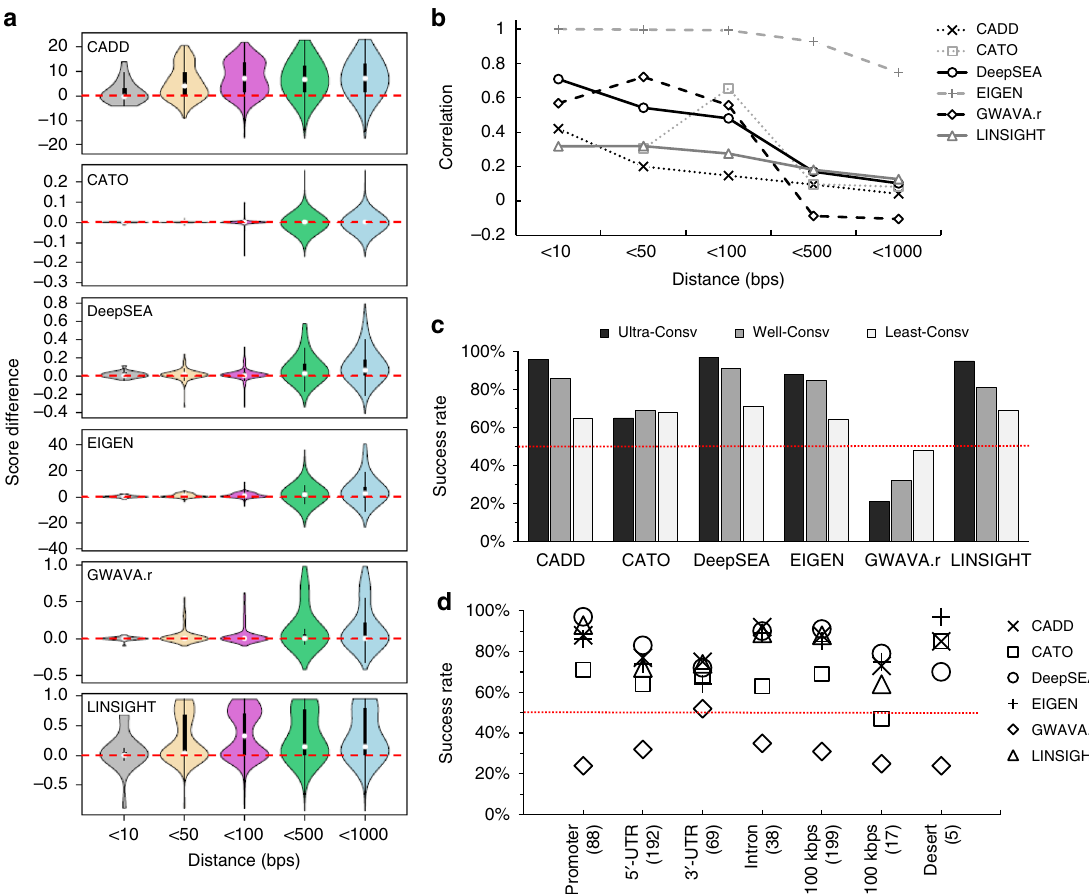
Fig. 2 Performance of tested methods on region-matched pathogenic and non-pathogenic ncSNVs. a Violin plots show distributions of impact score difference between nearby pathogenic and non-pathogenic ncSNVs. Variants were grouped into bins based on distances measured in base pairs. Positive values imply that the pathogenic variant has the higher score. b Correlation of impact scores for ncSNVs located within given genomic distances. Pearson correlation coef fi cient values are displayed. c Success rates of ranking a pathogenic ncSNV higher than a non-pathogenic ncSNV located within 1000 bps vicinity. Data are strati fi ed by conservation of the position harboring pathogenic ncSNVs. Since pathogenic and non-pathogenic variants are evaluated in pairs, the random expectation of success rates is 50% as represented by the red line. d Success rates strati fi ed by the genomic context of pathogenic ncSNVs, including promoters, 5 ’ - and 3 ’ - untranslated regions (UTRs), introns, near-gene ( + / − 100 kbps) regions and gene-desert regions. GWAVA represents GWAVA region-matched